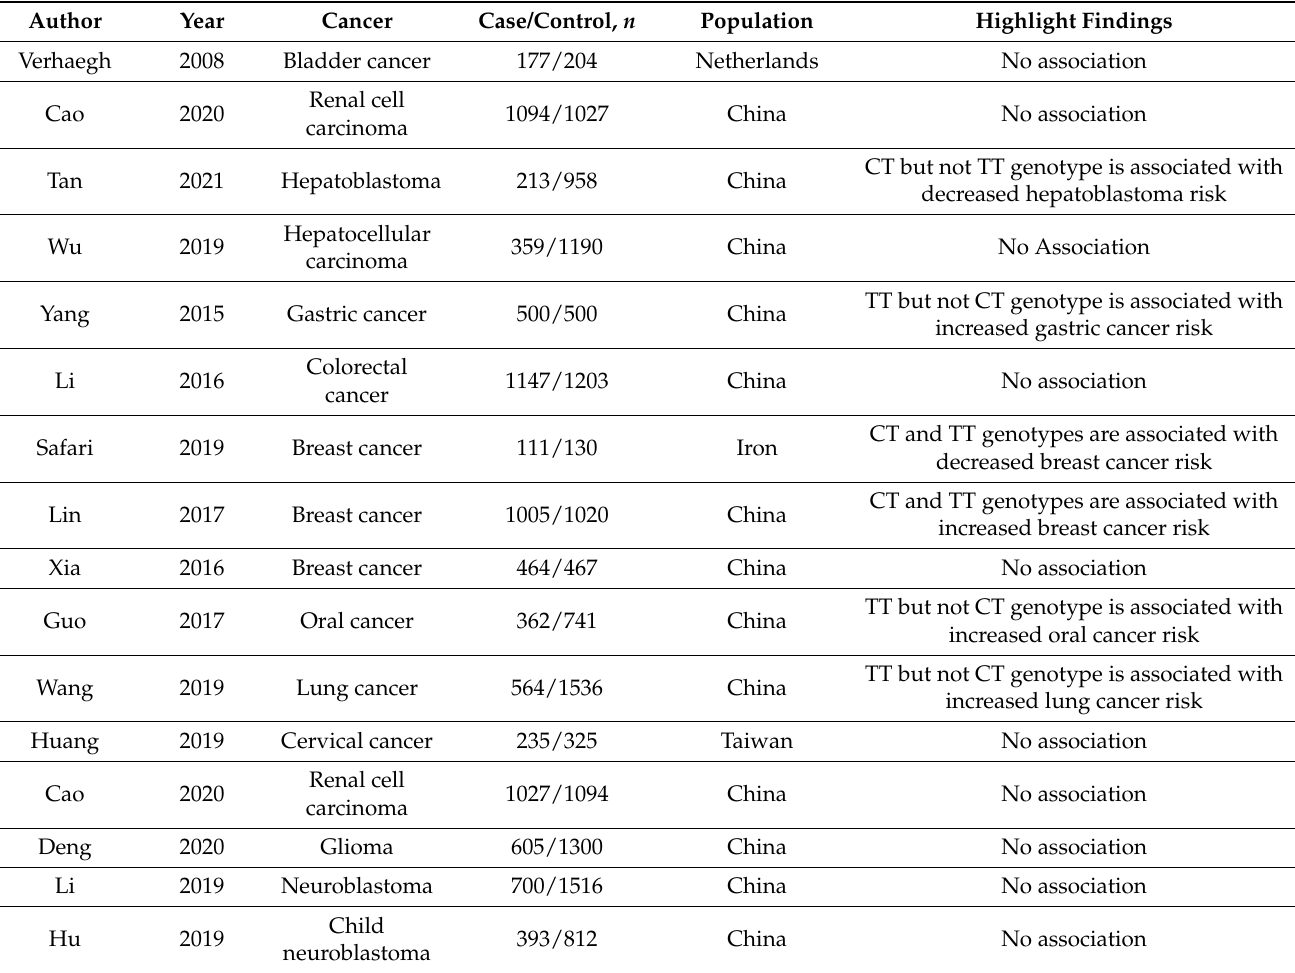
Table 8. The summary of genotypic findings for H19 rs217727 polymorphism among cancer